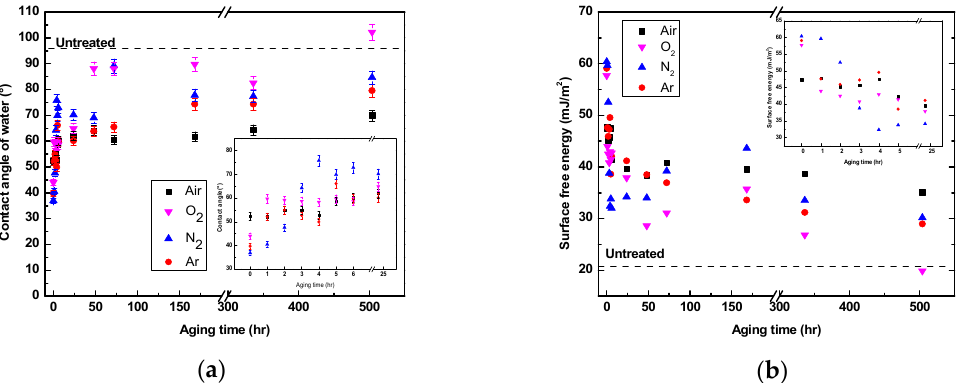
Figure 7. Evolution of the contact angle of ( a ) water and ( b ) surface free energy versus aging time for plasma treated PU using air, O 2 , N 2 , and Ar at 120 s.